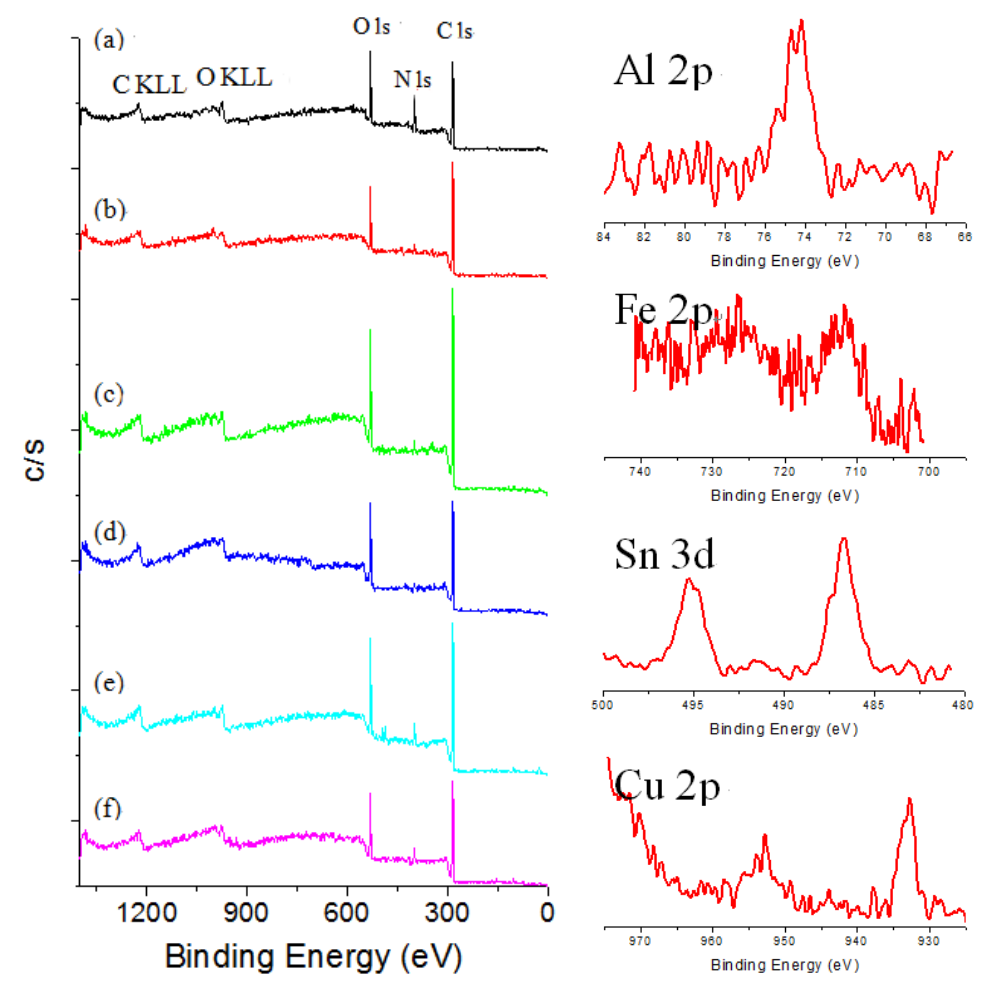
Figure 3. Survey XPS spectra of ( a ) undyed silk and sappanwood-dyed silk textiles; ( b ) without mordant and with various mordants: ( c ) KAl(SO ( f ) CuSO . 4